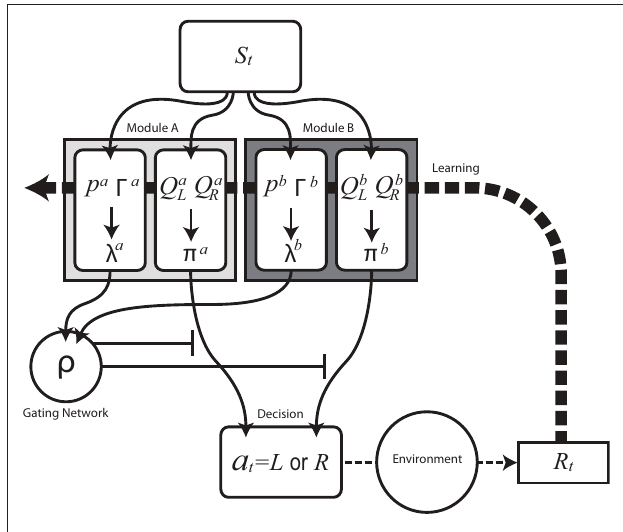
Figure 1 | Schematic diagram of modular reinforcement learning (rL) model. Each module m produces a responsibility λ m and a policy π m . Responsibility λ m is calculated based on the accumulated squared prediction error Γ m , which in turn is based on a comparison of a prediction p m of a feature of the environment with the actual feature (in this case the reward R ). The t module with greater λ m is selected based on the softmax selection rule r , which can be seen as a description of a gating network. The modular policy π m assigns each module’s probability of choosing each candidate action based on the modular action-value function Q m . The policy π m of the selected module determines the actual action a . The learning or updating of p m and Q m is t performed only within the selected module using the global reward signal R